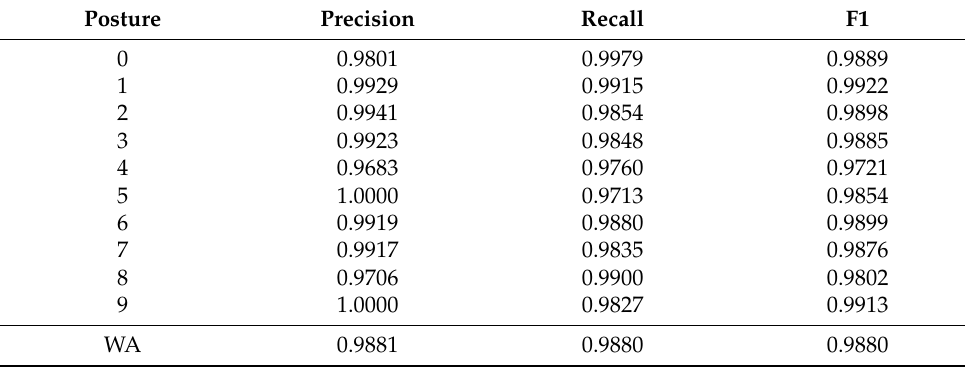
Figure 5. Confusion matrix of the results obtained from the ConvLSTM model. Table 3. Performance results of the ConvLSTM.